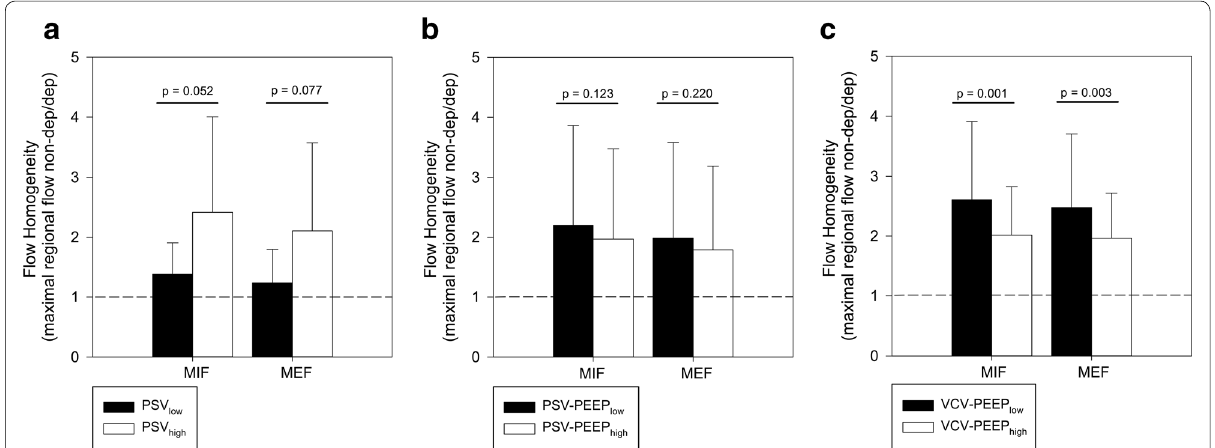
Fig. 3 Lower levels of pressure support improved homogeneity of regional maximal flow distribution both during inspiration and expiration in comparison with higher support (PSV low vs. PSV high ) ( a ); higher positive end‑expiratory pressure level led to an improvement in maximal inspiratory and expiratory flows (MIF and MEF) homogeneity both during pressure support ventilation (PSV‑PEEP high vs. PSV‑PEEP low ) ( b ) and volume‑controlled